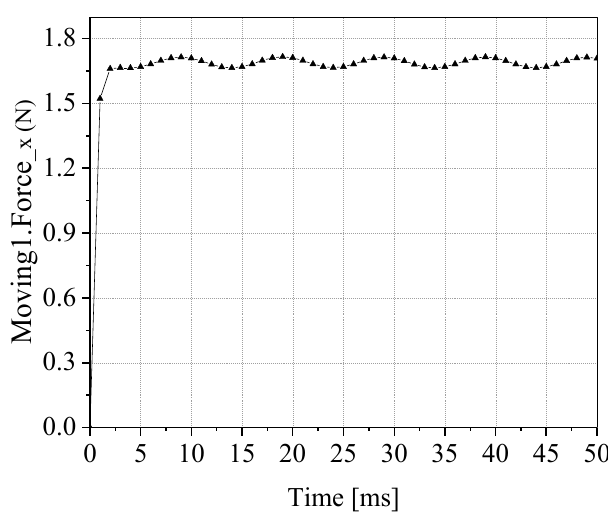
Figure 5. The electromagnetic thrust generated by the original model.